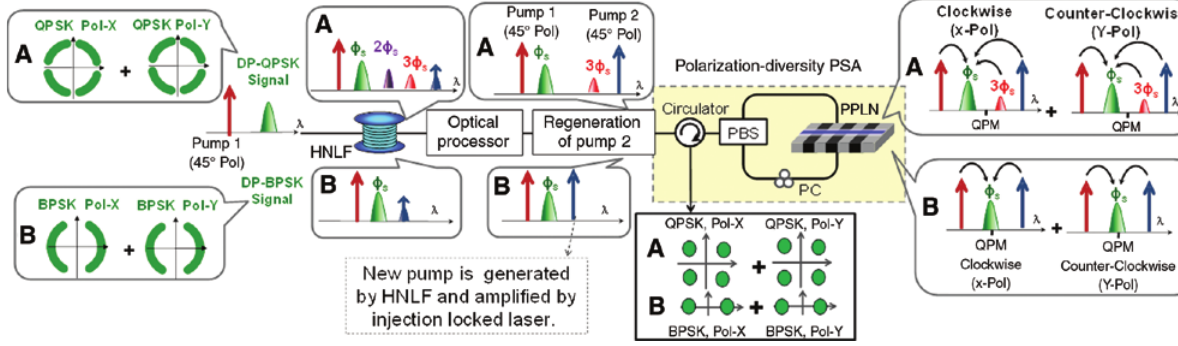
Figure 23: Non-degenerate PSA phase squeeze system design.